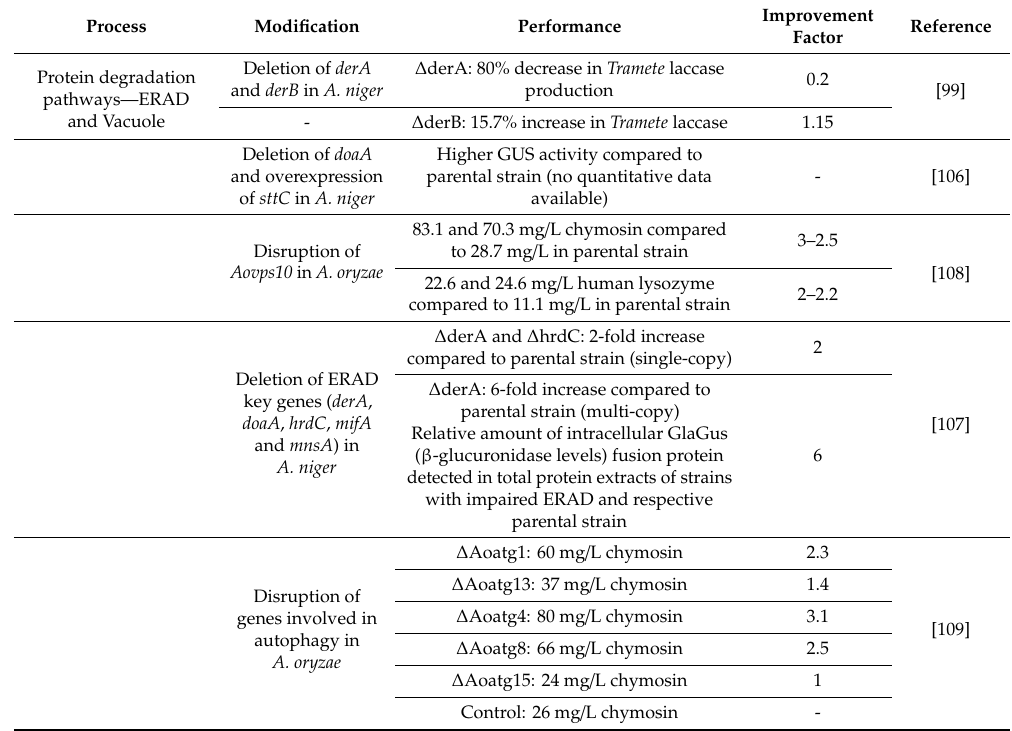
with Table 8. Approaches for improving recombinant protein production through engineering protein degradation